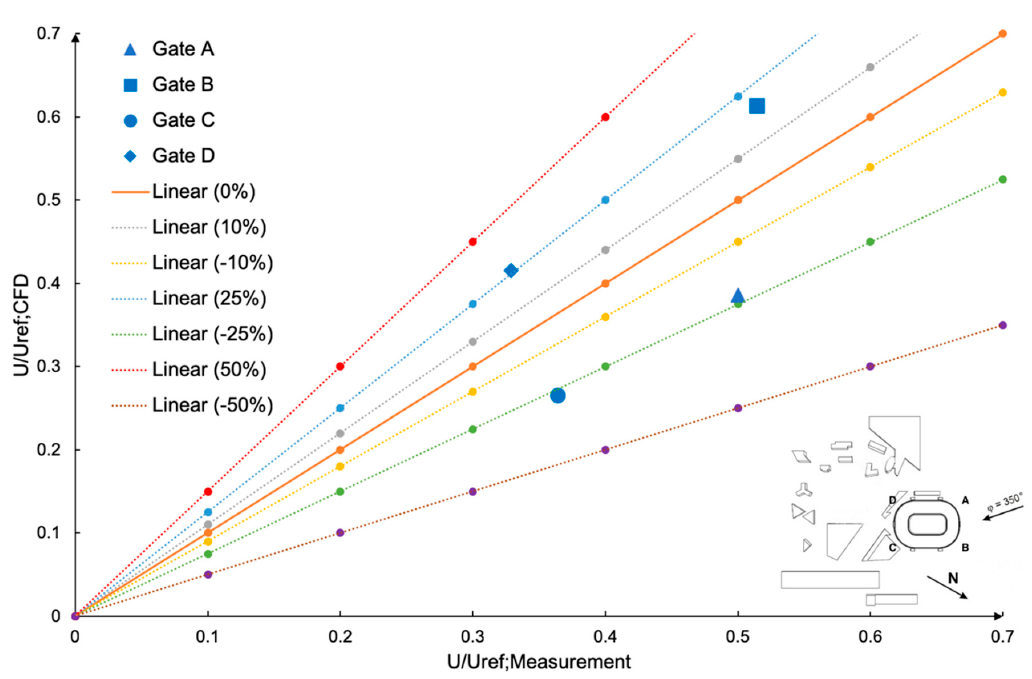
Figure 6. Comparison between current Computational Fluid Dynamics (CFD) results and previous field measurements under the wind direction of